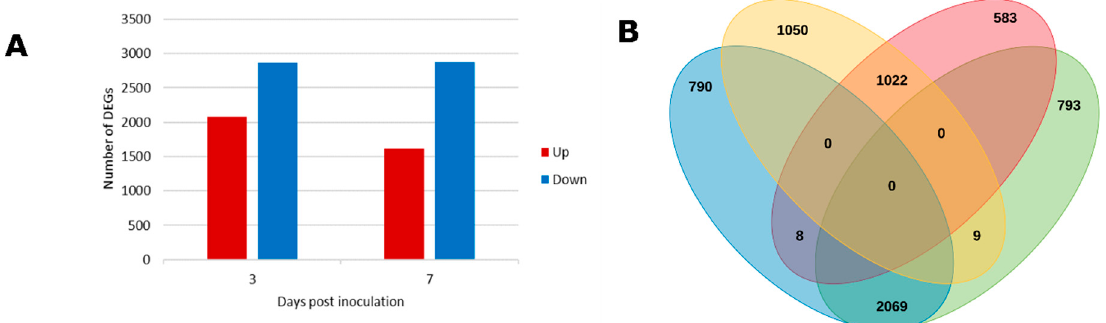
Figure 2. Schematic representation of differentially expressed genes in potato roots following Meloidogyne javanica infestation (A) Number of differentially expressed genes detected at 3 and 7 dpi compared to the mock-inoculated samples. ‘Down’ designates down-regulated genes. ‘Up’ designates up-regulated genes. (B) Venn diagram of the distribution of differentially expressed genes between 3 and 7 dpi. Yellow and blue ovals represent up-regulated and down-regulated differentially expressed genes at 3 dpi, respectively. Red and green ovals indicate the genes up-regulated and down-regulated at 7 dpi, respectively.